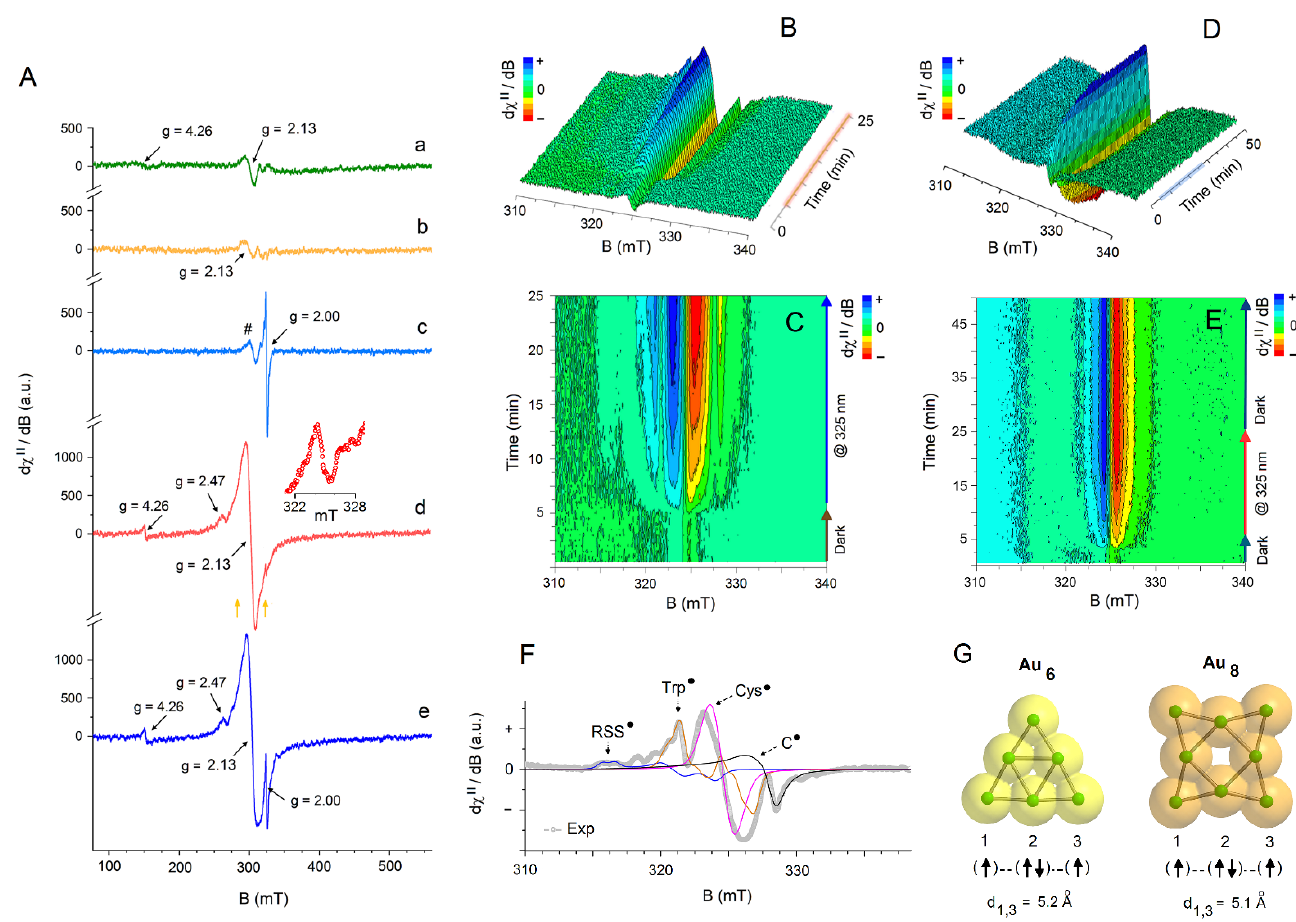
Figure 2. Panel ( A ) CW X-band Electron Paramagnetic Resonance (EPR) spectra recorded in water at T = 90 K under dark conditions of (a) HAuCl 4 , (b) BSA, and (d) AuBSA. The LEPR spectra obtained under in situ UV irradiation (@325 nm, for 10 min) of the frozen matrix solutions for the various samples ( T = 90 K) are given as trace (c) for BSA and trace (e) for AuBSA. Note that in trace (c), the symbol (#) indicates the region in which the g x component of the thyil radical (Cys • ) in BSA is expected to be observed. The in situ 3D/2D LEPR experiment ( T = 90 K, water) for BSA is shown in panel ( B ) and panel ( C ); panel ( D ) and panel ( E ) show the 3D/2D LEPR experiment for AuBSA. Panel ( F ) gives the experimental EPR spectrum ( T = 90 K) together with computer simulations of the individual spin components obtained for neat BSA in water after 20 min of continuous UV irradiation. Panel ( G ) shows the structural organization of gold nanoclusters (Au 6 and Au 8 ) derived from DFT theory (neutral forms, coordinate files taken from ref. [67]) encoding the minimum dimensions for the Au nano-assemblies in BSA that are compatible with the distances calculated by EPR for a pair of spin–spin interacting Au(II)/Au(0) centers (labelled as